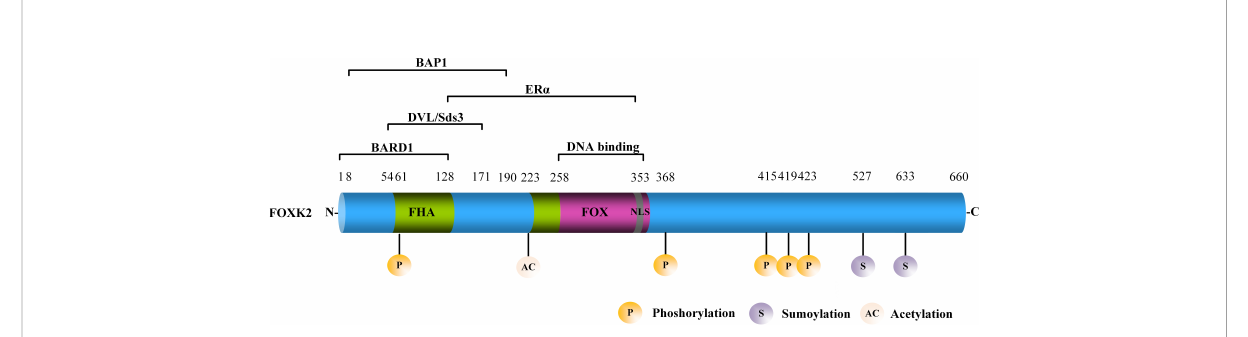
FIGURE 1 The structure of FOXK2. FOXK2 comprises a FHA, FOX domain, and NLS. Well-known proteins that interact with FOXK2 are shown above the corresponding domains. The post-translational modi fi cation (PTM) sites of FOXK2 are